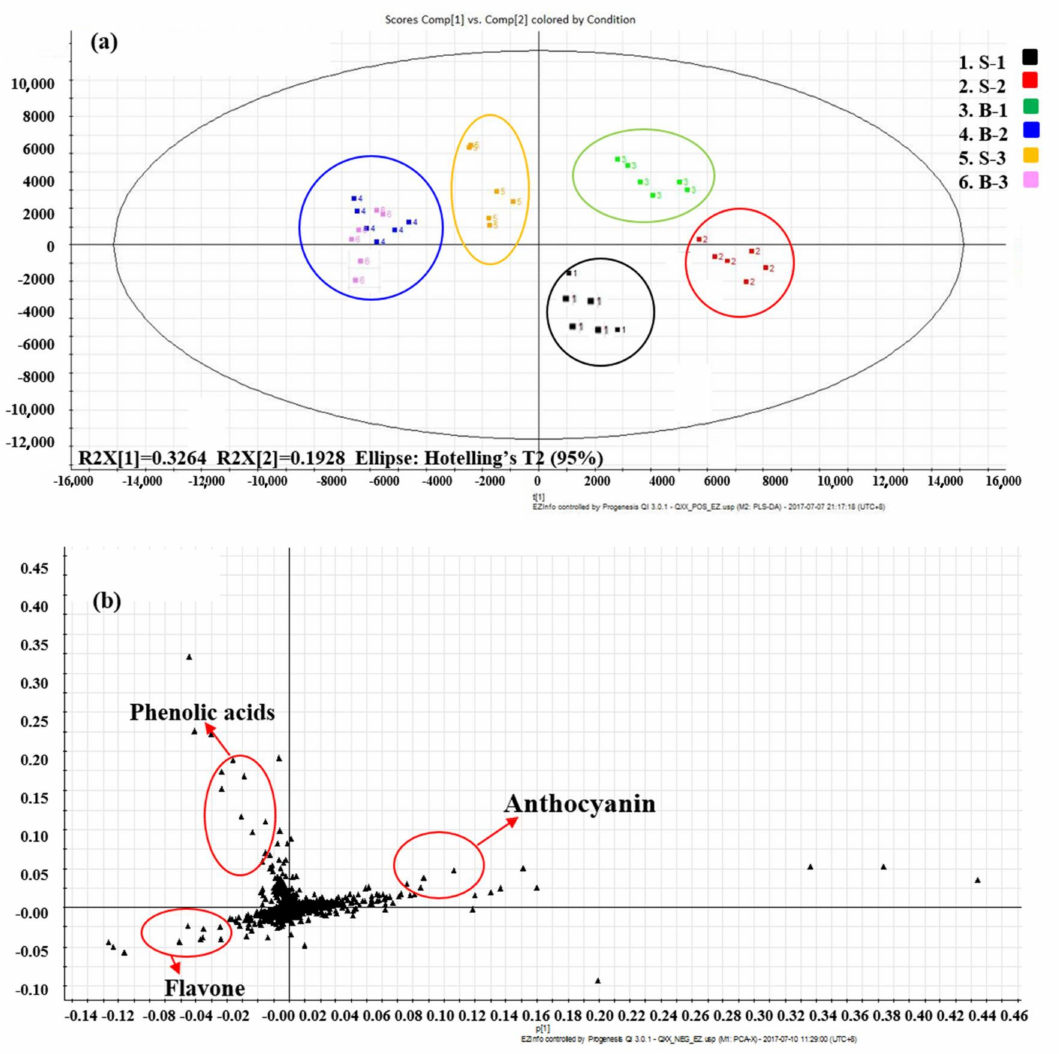
Figure 2. Orthogonal partial least squares–discriminate analysis (OPLS-DA) of six red-lettuce cultivars analyzed via UHPLC–Quadrupole–Orbitrap MS/MS (every cultivar included six independent biological replicates). ( a ) Score plot. ( b ) Loading